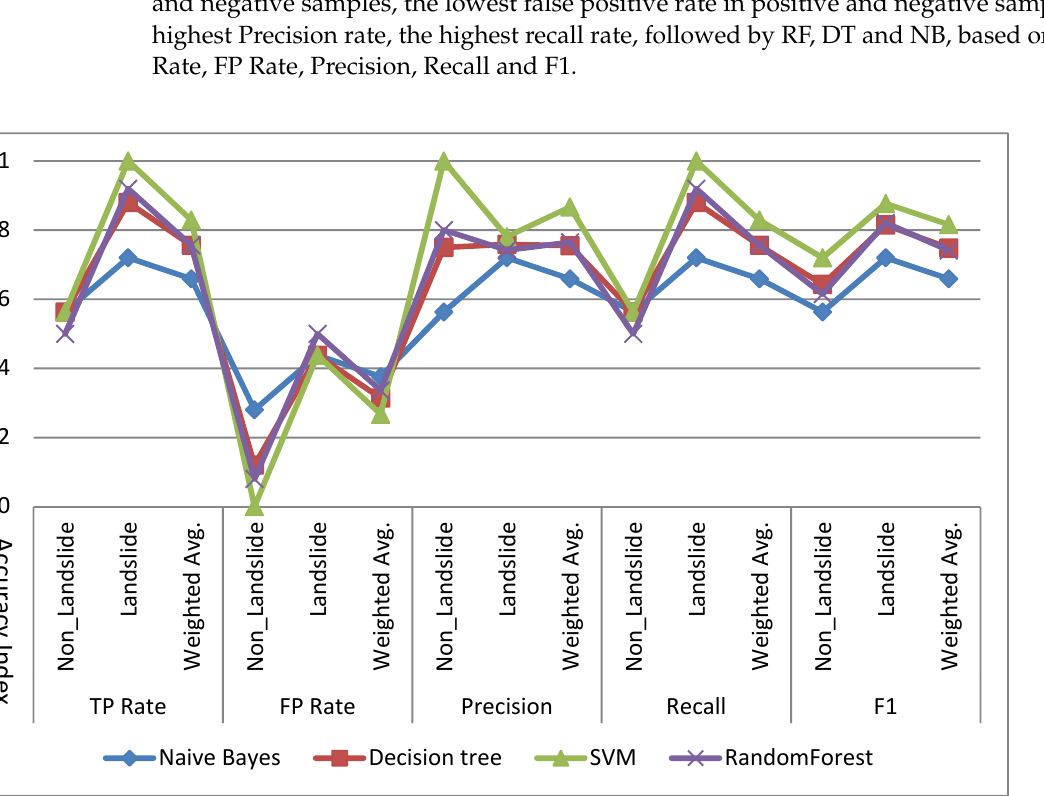
Figure 10. Comparison of TP Rate, FP Rate, Precision, Recall and F1.